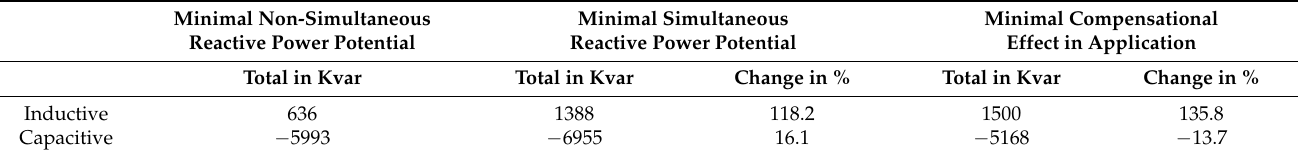
Table 3. Comparison between minimal simultaneous and non-simultaneous reactive power potential.